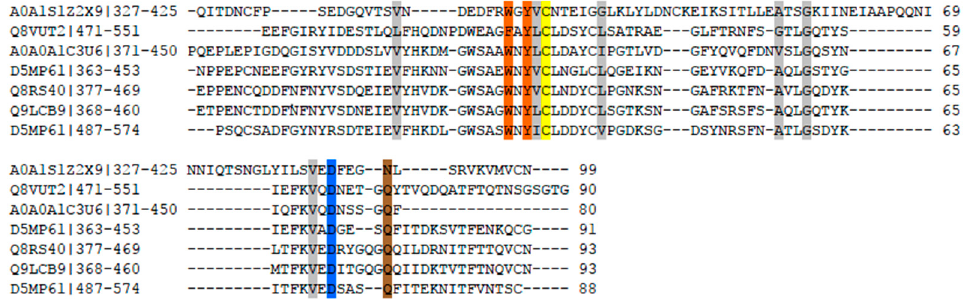
Figure 10. Multiple sequence alignment of CBM (carbohydrate-binding module) with Xyl88 hypothesis CBM.